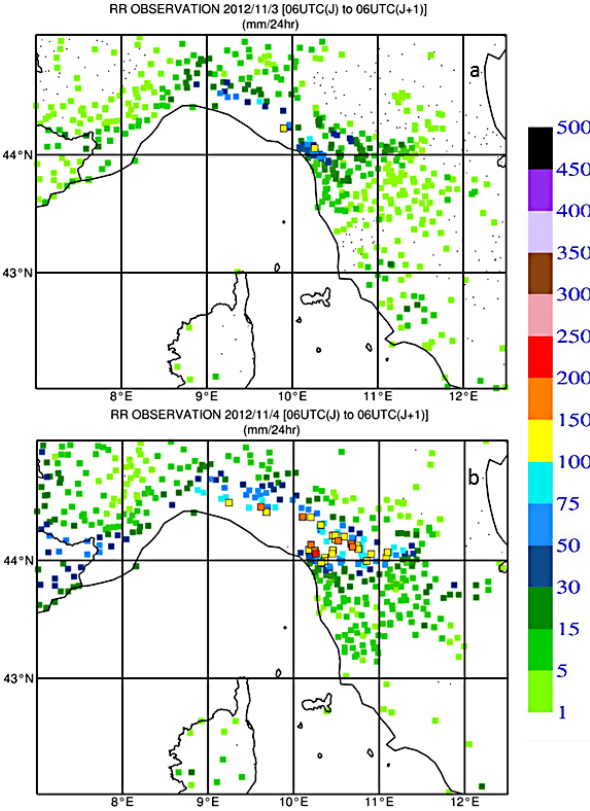
Figure 19. Observed 24h accumulated precipitation ending at 06:00UTC on (a) 3 November 2012; (b) 4 November 2012 (source: